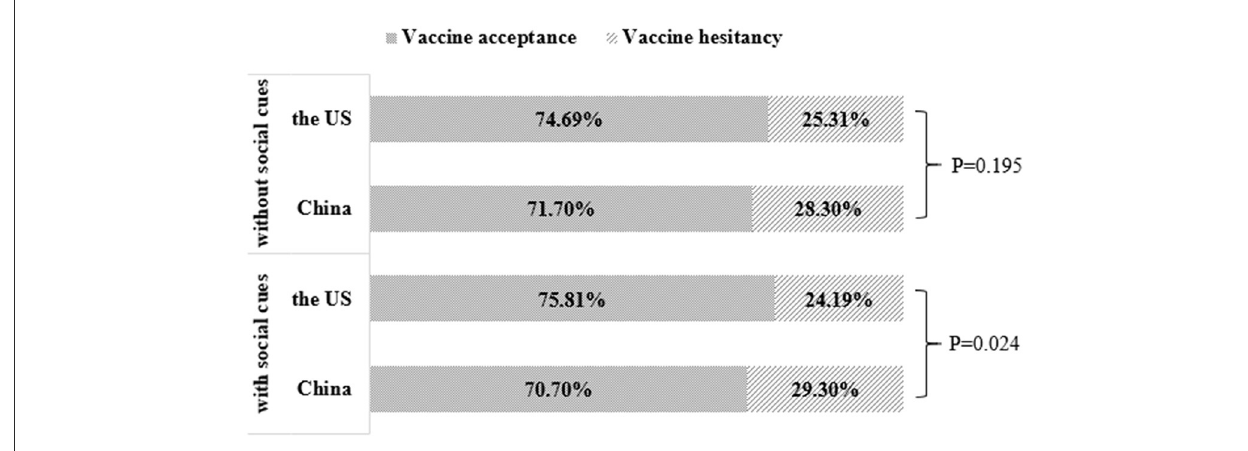
FIGURE2 COVID-19 vaccination acceptance comparison between China and the US depending on social cues.